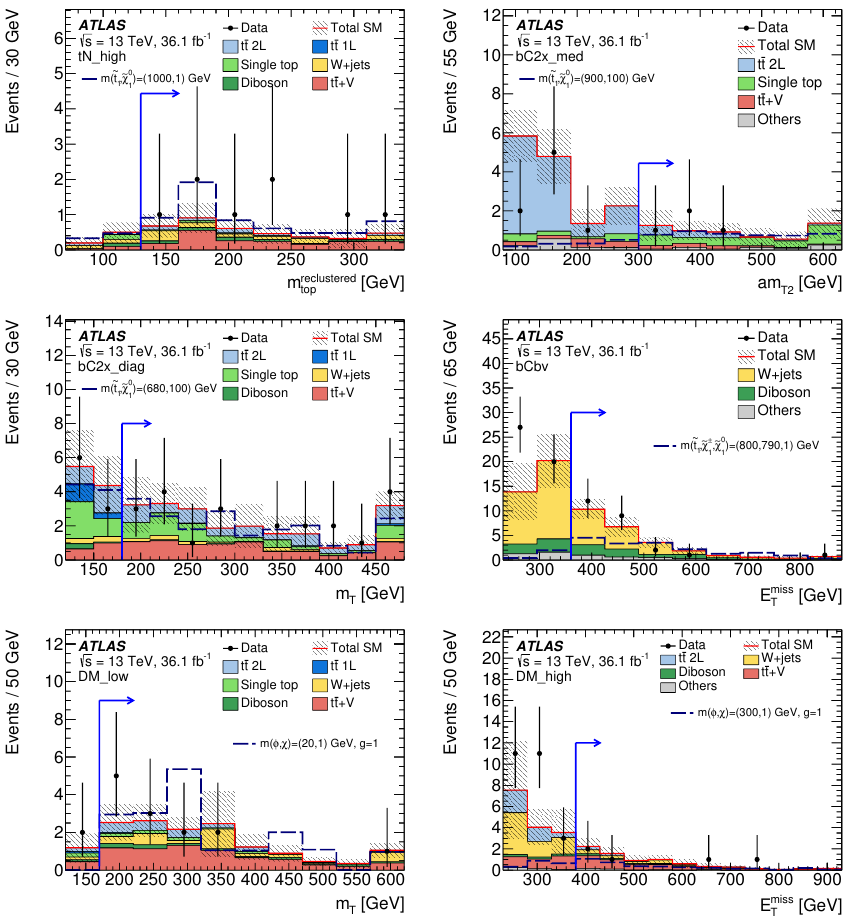
Figure 17 . Kinematic distributions in the signal regions: (top left) m reclustered in tN high , (top top right) am T2 in bC2x med , (middle left) m T in bC2x diag , (middle right) E miss in bCbv , (bottom left) T m T in DM low , and (bottom right) E miss in DM high . The full event selection in the corresponding T signal region is applied, except for the requirement (indicated by an arrow) that is imposed on the variable being plotted. The predicted SM backgrounds are scaled with the normalisation factors obtained from the corresponding control regions in tables 23 and 24. In addition to the background prediction, a signal model is shown on each plot. In the DM+ t (cid:22) t signal model, a coupling of g = 1 is assumed. The category labelled ‘Others’ stands for minor SM backgrounds that contribute less than 5% of the total SM background. The hatched area around the total SM prediction includes statistical and experimental uncertainties. The last bin contains